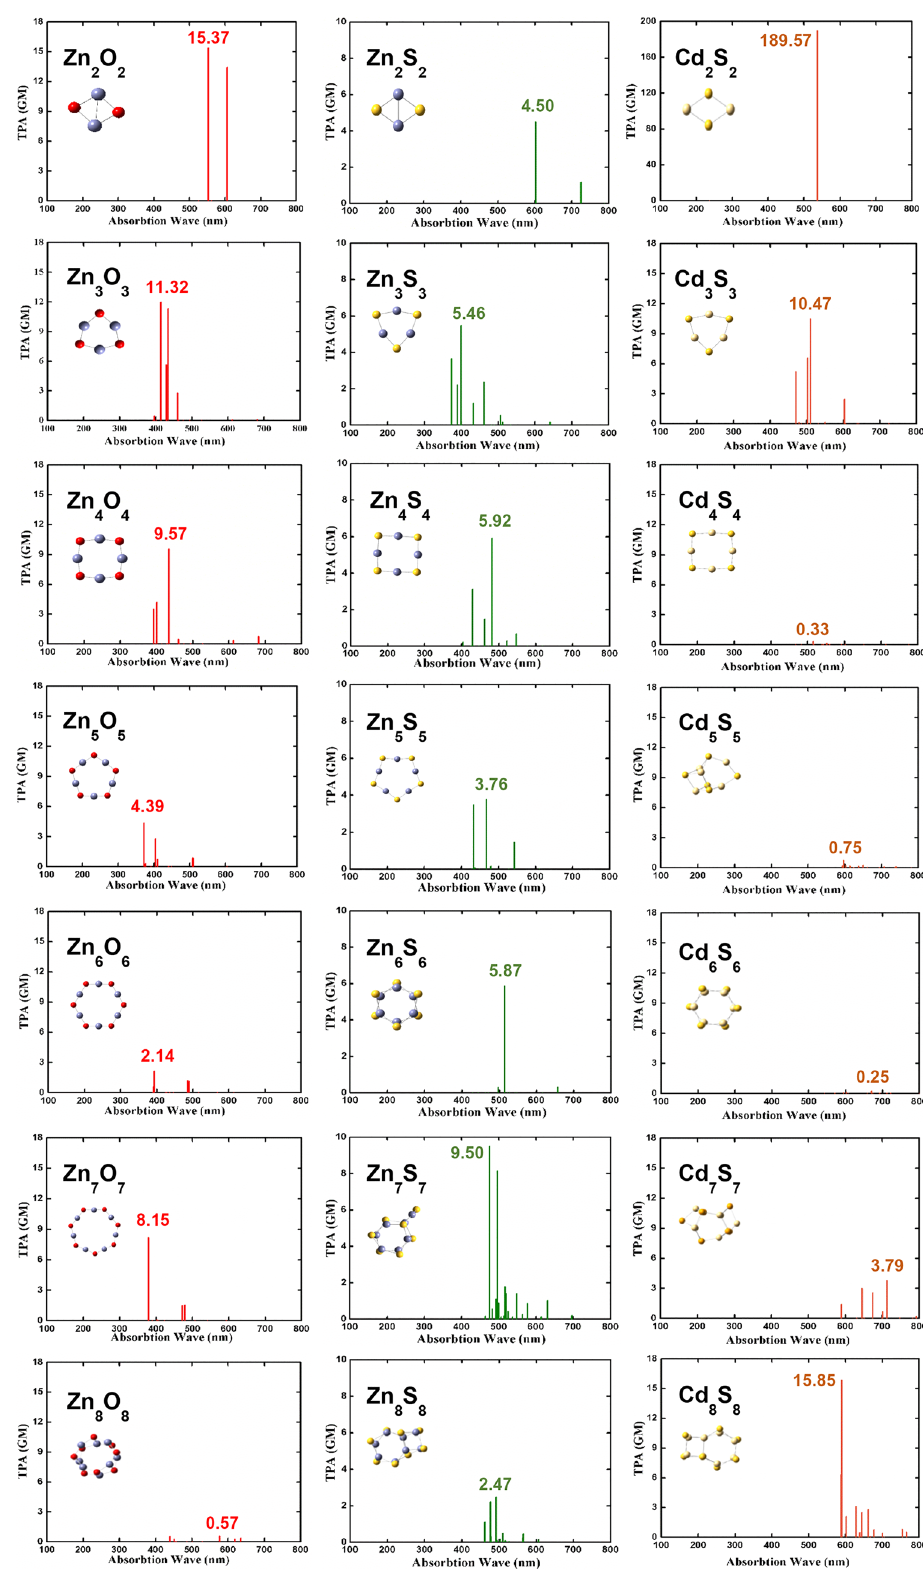
Figure 5. Calculated TPA cross sections of Zn n O n , Zn n S n , and Cd n S n , n =